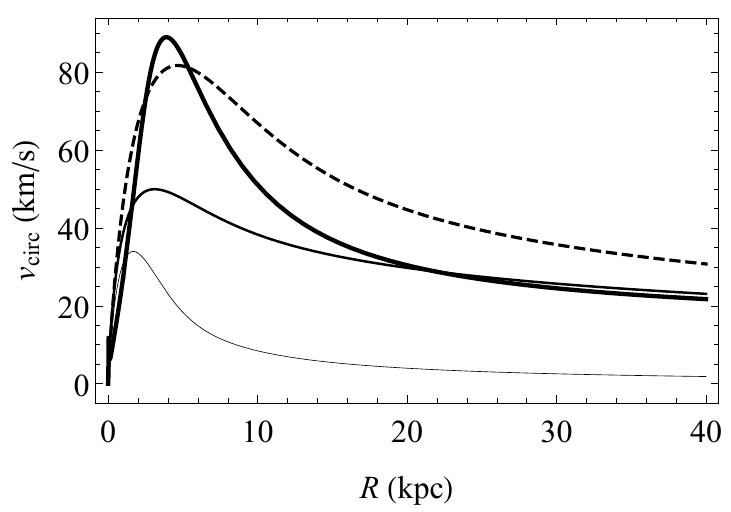
Figure 9 . Rotation curve of baryonic matter in the thin-disk approximation and an exponential matter density profile (A.31) in Einstein’s theory (eq. (A.34), dashed curve) and in the multi- fractional theory T with q -derivatives (eq. (5.23)) for α = 1 . 5 and A = 0 = B , α = 0 . 5 and A = q 0 = B , and α = 0 . 5 and 5 harmonics all with amplitudes A = 0 . 2 , B = 0 and parameter N = 10 10 (solid curves of increasing thickness). Here M = 1 . 72 × 10 40 kg , R